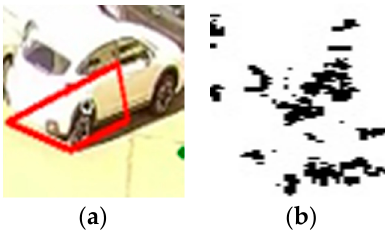
( a ) ( b ) Figure 6. The image of ( a ) occupied parking space); ( b ) the result of SIFT corner detector.